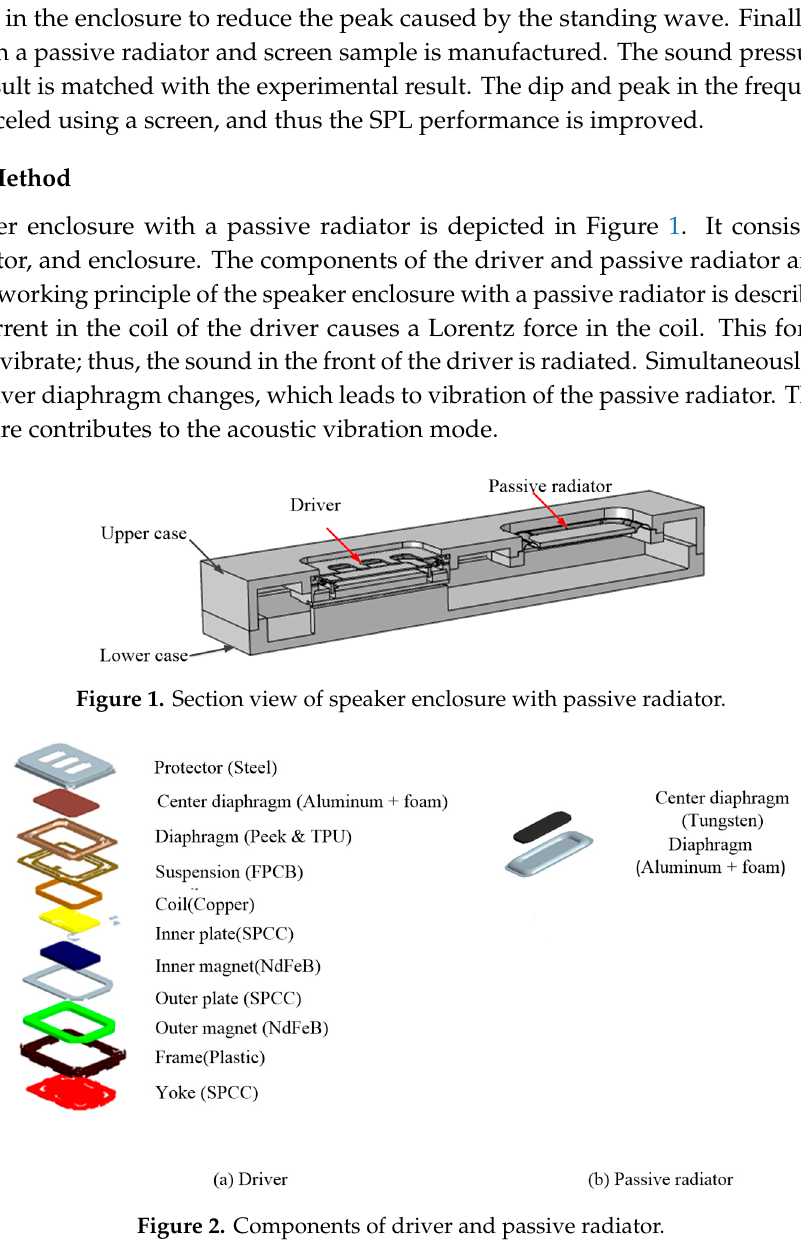
Figure 2. Components of driver and passive radiator.